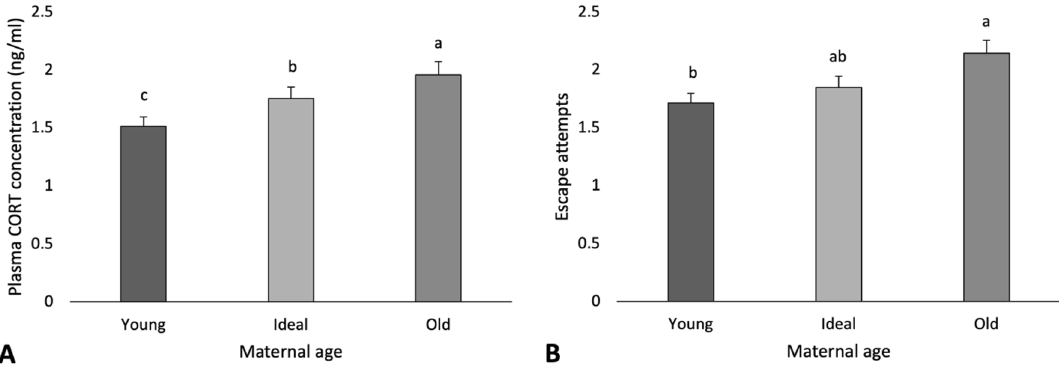
Figure 2. Manual restraint test. ( A ) Average plasma corticosterone concentration (ng/ml) and ( B ) average number of escape attempts displayed by maternal age. Statistical differences within tests are indicated by letters (a–c) (P <